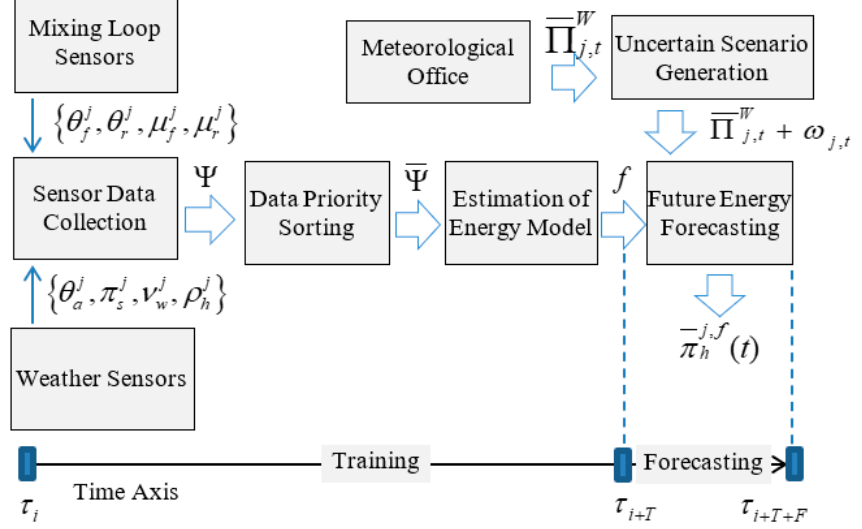
Figure 2. General overview of training and forecasting approaches to estimate heat consumption of buildings.